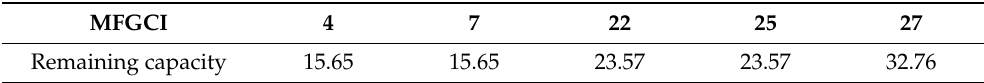
Table 7. Total remaining capacity and maximum and minimum capacity required for harmonic mitigation (kW). Table 6. Remaining capacity of MFGCI at 13:00 (kW).